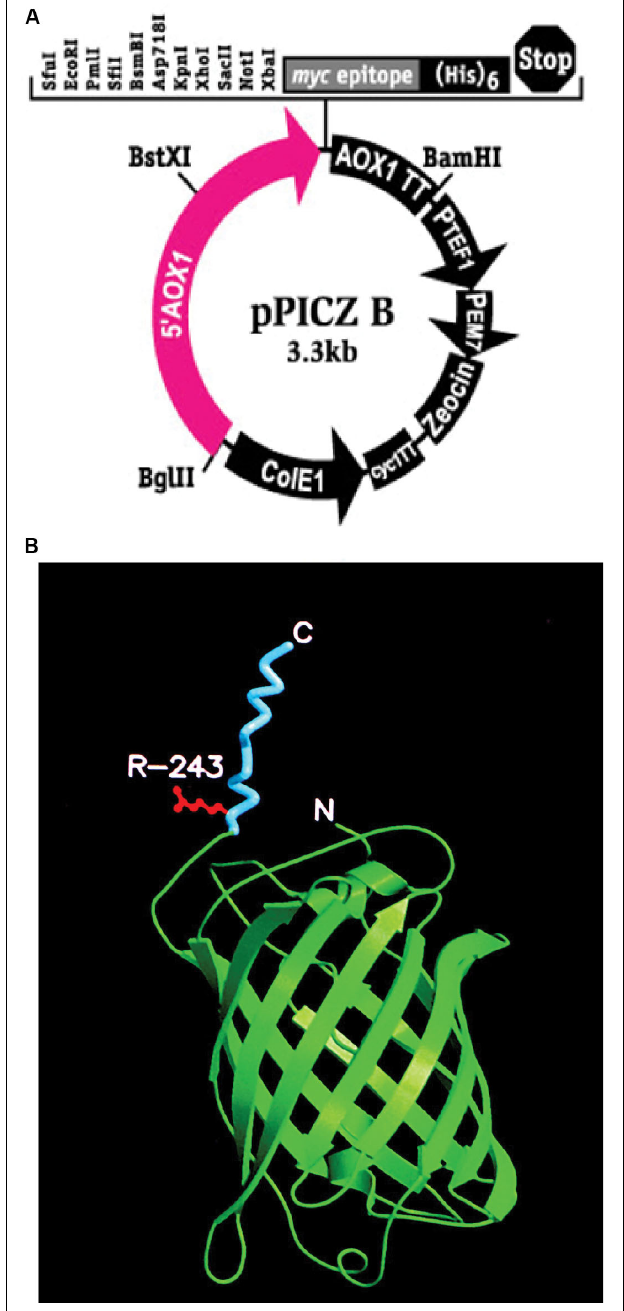
FIGURE 1 | (A) pPICZB plasmid that was used to transform KM71 and KM71H cells. The plasmid multiple cloning site is shown including the positions of the restriction enzyme pairs Xba I and Kpn I and Xba I and Xho I that were used to clone gfp - tm fA and tmf A, respectively. Shown also is the P AOX 1 and the restriction enzyme position for Bst XI used to open the plasmid for homologous recombination. The arrows indicate the direction of replication. (B) A 3D model of the recombinant fusion protein GFP-TMOF including R243 where mosquito larva cleaves the fusion protein in the gut releasing TMOF. The carboxyl and amino ends are denoted as C and N, respectively. TMOF (blue) assumes a left handed conformation and GFP green a barrel conformation made of β -pleated